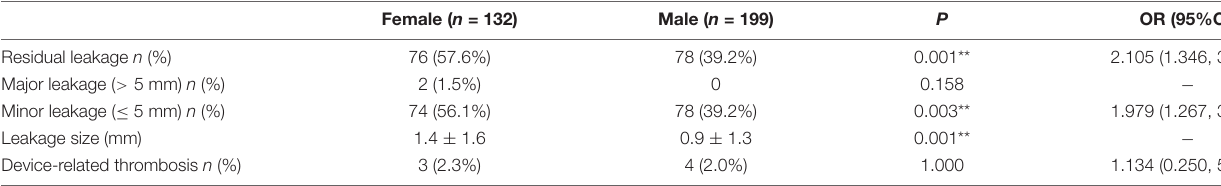
TABLE 3 | Results of TEE follow-up at postoperative 45 days.